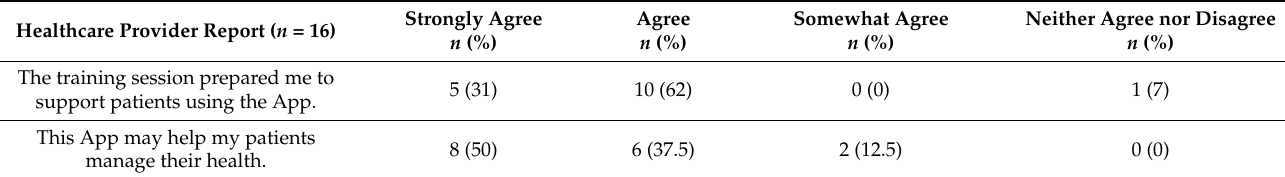
Table 4. Overview healthcare provider quality improvement feedback on platform and training